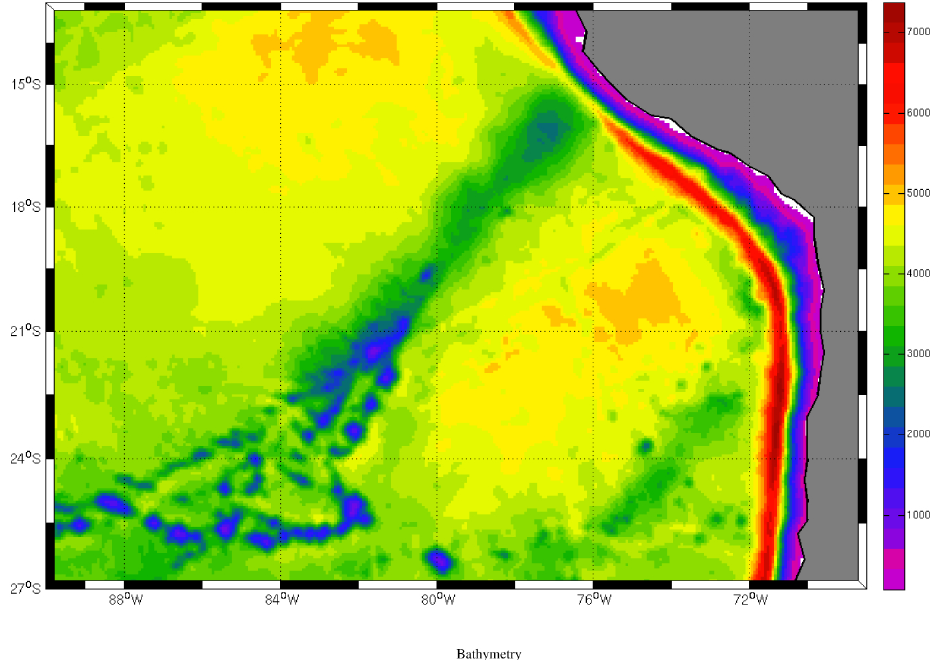
Fig. 2. Horizontal domain used for the ROMS experiments with the model bathymetry (color) plotted in meters depth. The Nazca ridge cuts across the domain diagonally changing depths on either side from 5000 to